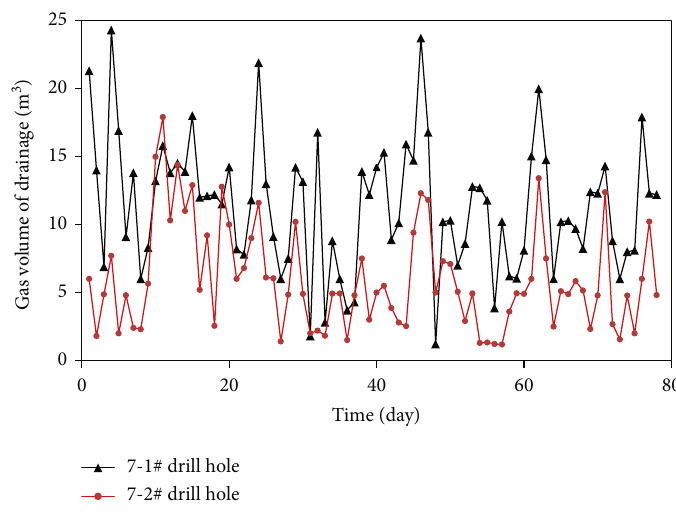
Figure 12: Gas extraction in the borehole group 7#.